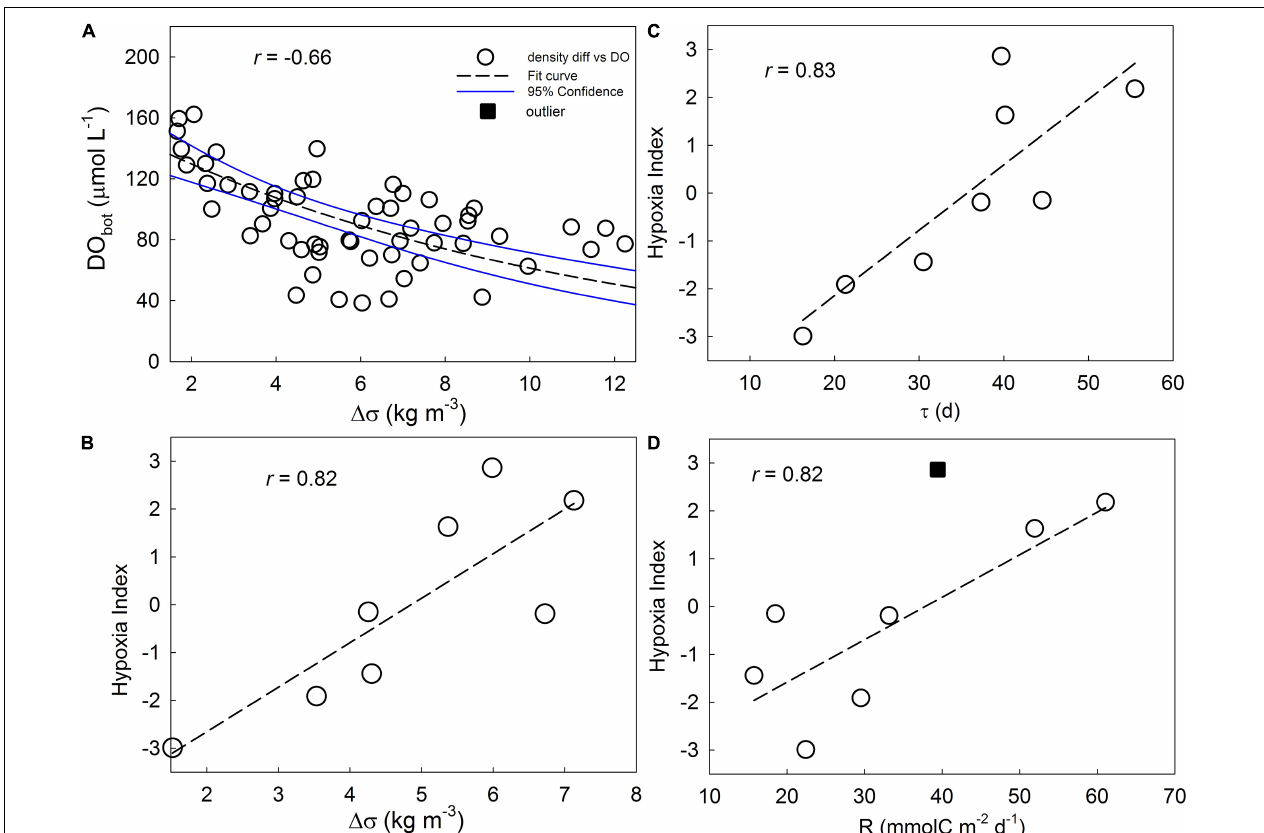
FIGURE 3 | Correlations between (A) bottom DO and (cid:49) σ of stations between 122.3–124 ◦ E during summers of the 8 years along the transect, (B) HI and mean (cid:49) σ of all stations, (C) HI and residence time ( τ ) under mixed layer depth (MLD), and (D) hypoxia index (HI) and R in hypoxia area (R hy ) for 8